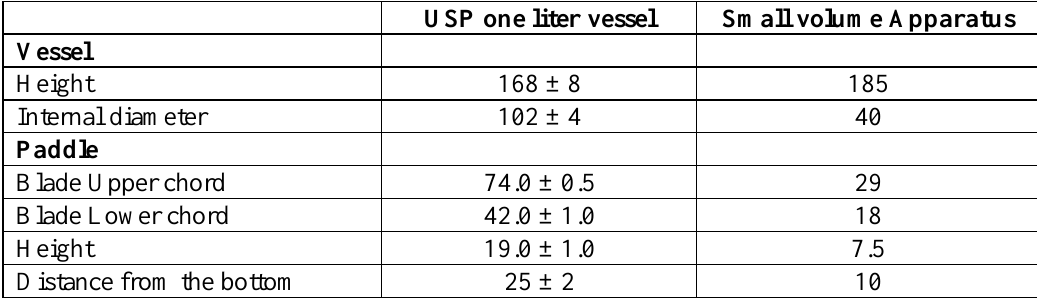
Table 1. Dissolution – Difference in Dimension (mm) of the small and USP Vessels and Paddle.